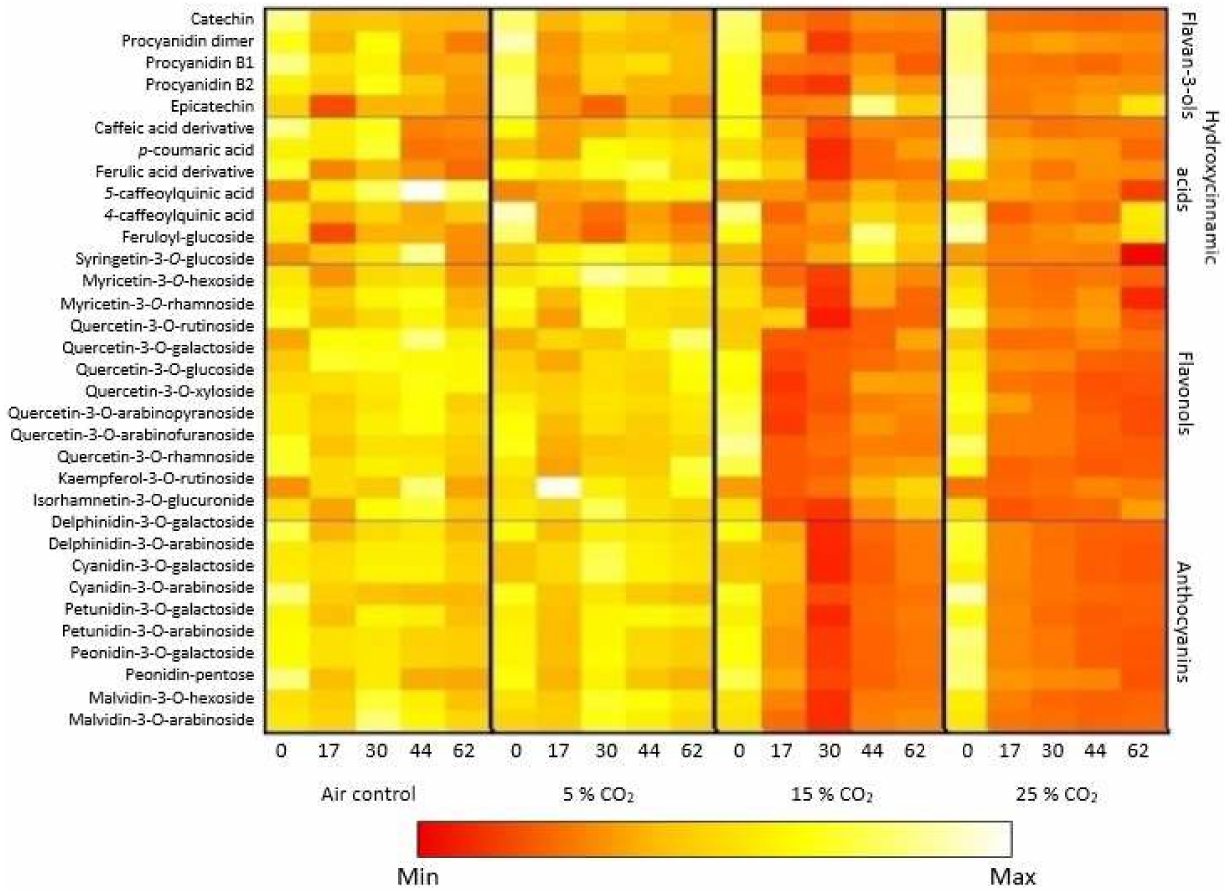
Figure 5. Heatmap for blueberry ‘Liberty’ fruit individual phenolics contents under the air control and controlled atmo- spheres (5% CO 2 , 5% O 2 , 90% N 2 (5%); 15% CO 2 , 5% O 2 , 80% N 2 (15%); and 25% CO 2 , 5% O 2 , 70% N 2 (25%)) for different storage times. Red, low individual phenolics content; white, high individual phenolics